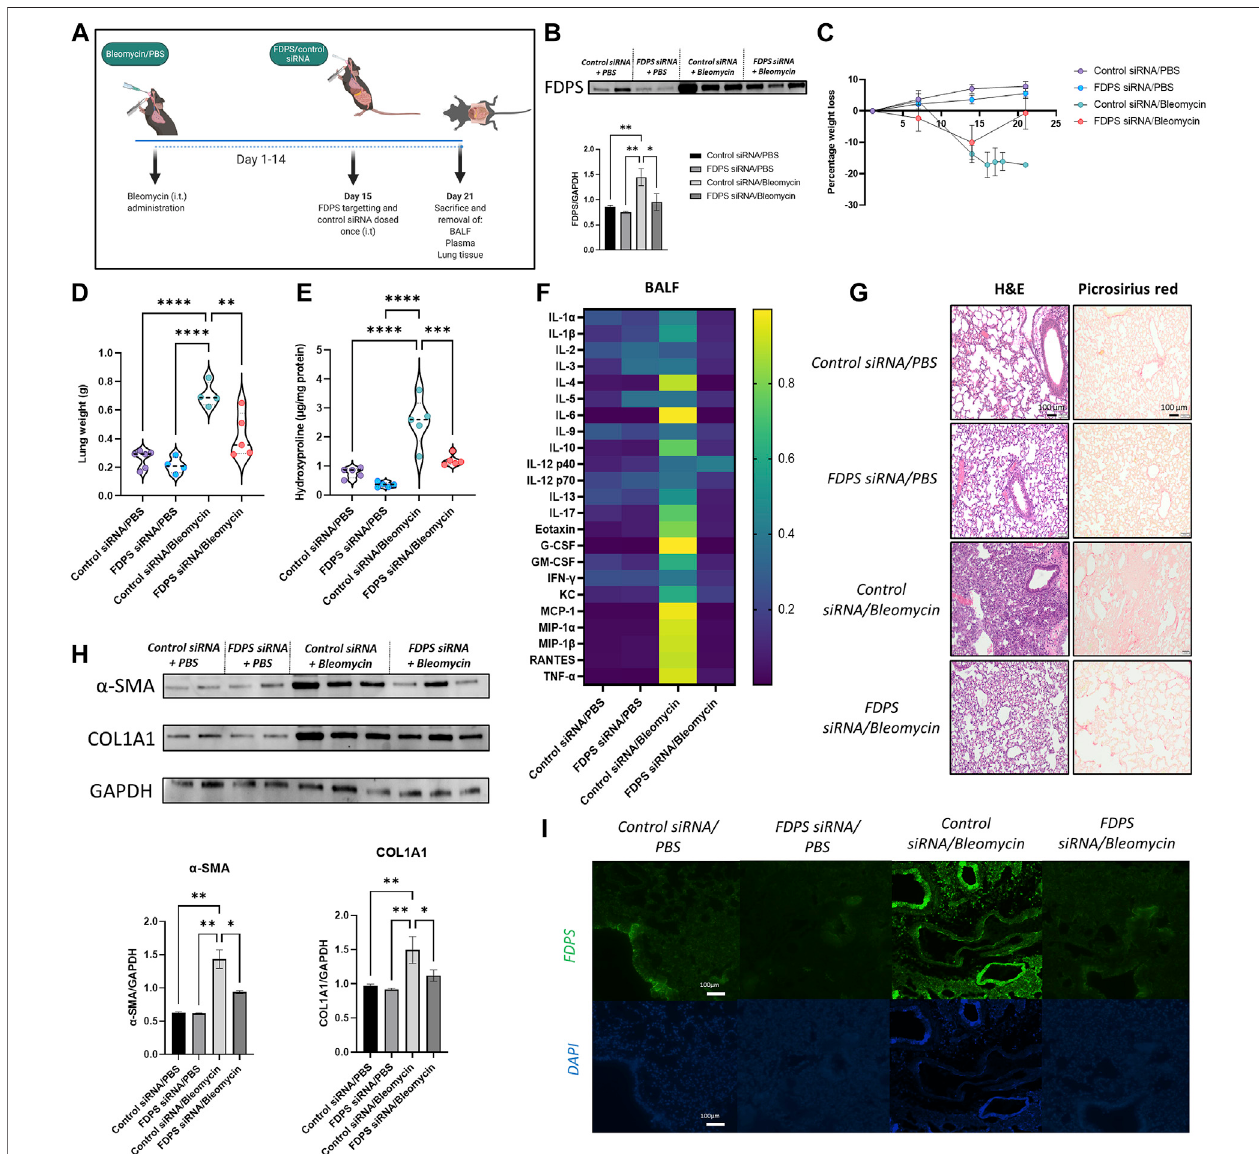
FIGURE 7 | Intratracheal administration of FDPS siRNA confers protection to bleomycin-challenged mice. (A) Mice were subjected to bleomycin treatment at day 0, administrated FDPS or control siRNA intratracheally on day 15 and sacri fi ced on day 21. (B) SDS-PAGE followed by western blot analysis using antisera speci fi c for FDPS in mouse lung homogenates con fi rms signi fi cantly decreased levels of FDPS after siRNA administration. Samples were compared using a one-way ANOVA followed by a Dunnett ’ s post-hoc test (* p < 0.05, ** p < 0.01). (C) Measurement of murine weight loss following bleomycin exposure shows a protective effect of FDPS siRNAcompared tocontrolsiRNA. (D) Bleomycininducedincreasesinmurinelungweightsweresigni fi cantlyreducedafterFDPS siRNAtreatments compared to control siRNA. Comparison between groups were performed using a one-way ANOVA followed by a Dunnett ’ s post-hoc test (** p < 0.01, **** p < 0.0001). (E) Hydroxyproline levels, which is a measurement of collagen content, was signi fi cantly increased in mice treated with bleomycin/control siRNA compared to the FDPS siRNA treated mice. Differences between groups were calculated with a one-way ANOVA followed by a Dunnett ’ s post-hoc test (*** p < 0.001, **** p < 0.0001). (F) Heatmap showing the difference in in fl ammatory cytokine levels in BALF between treatment groups (blue indicating low value; yellow indicating high value). (G) Bleomycin/control siRNA mice showed increased lung damage, determined by H&E, and more intense collagen staining (picrosirius red). Lungs from mice receiving FDPS siRNA were resembling lungs from control mice regarding both H&E and collagen. (H) Detection and quanti fi cation of the fi brotic proteins α -smooth muscle actin ( α -SMA) and collagen (COL1A1) using SDS-PAGE followed by western blot revealed a signi fi cant increase in both proteins in lungs from bleomycin/control siRNA mice, which was reduced signi fi cantly with FDPS siRNA treatment. (I) Immuno fl uorescence staining of lung sections with anti FDPS antibodies displaying an increase immunoreactivity in bleomycin/control siRNA mice, whereas lungs from mice administered FDPS siRNA were similar to lungs from control mice.